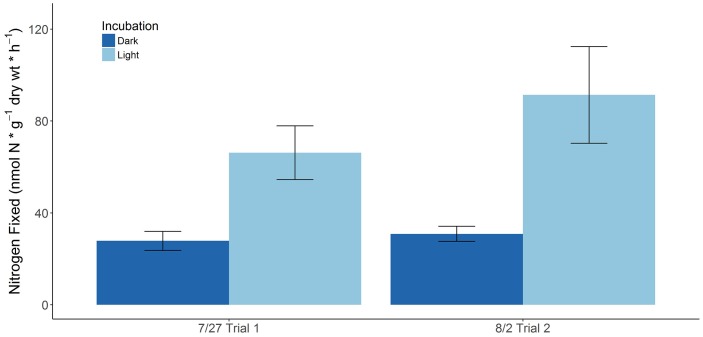
BNF rates associated with juvenile S. horneri recruits on two separate trials (error bars represent SE).